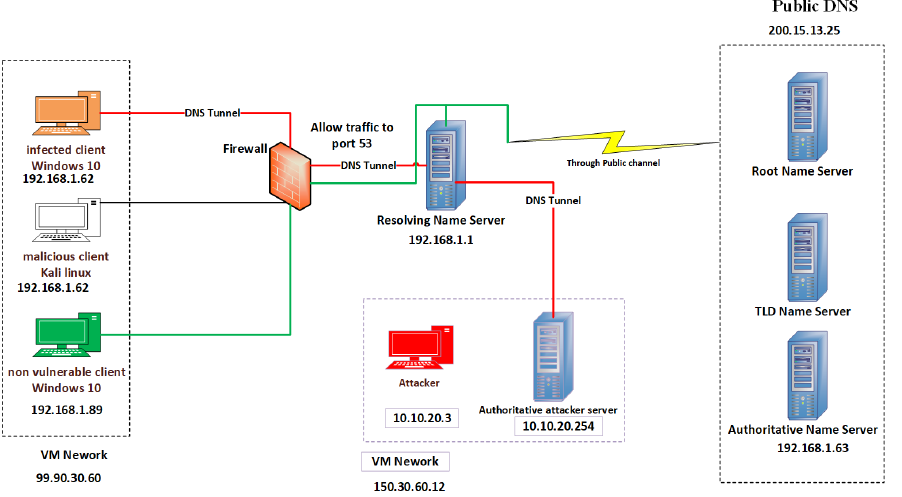
Figure 4. Illustration of proposed testbed environment using VM.